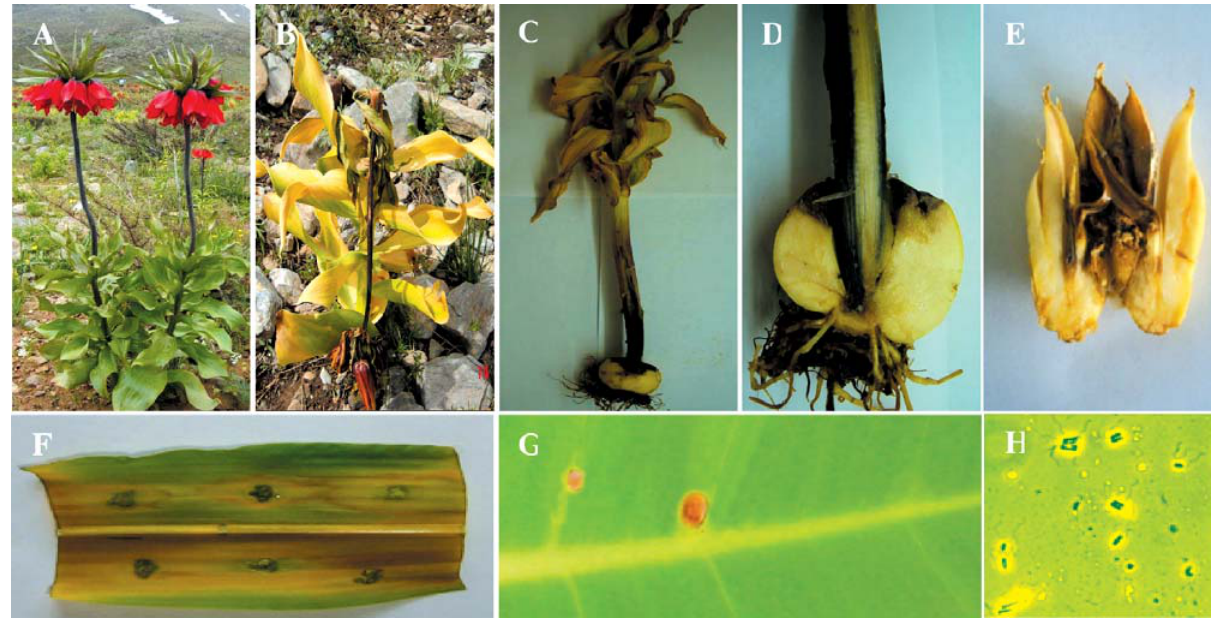
Fig. 1. A, Healthy plant; B, Infectious plant in the field; C, D, symptoms of black and soft rot on bulb; E, first stage of Pectobacterium carotovorum subsp. carotovorum (pcc) soft rot on bulb; F, water-soaked and necrosis lesion of pcc on corn leaf; G, effect of pcc on philodendron; H, peritrichous flagella of pcc.